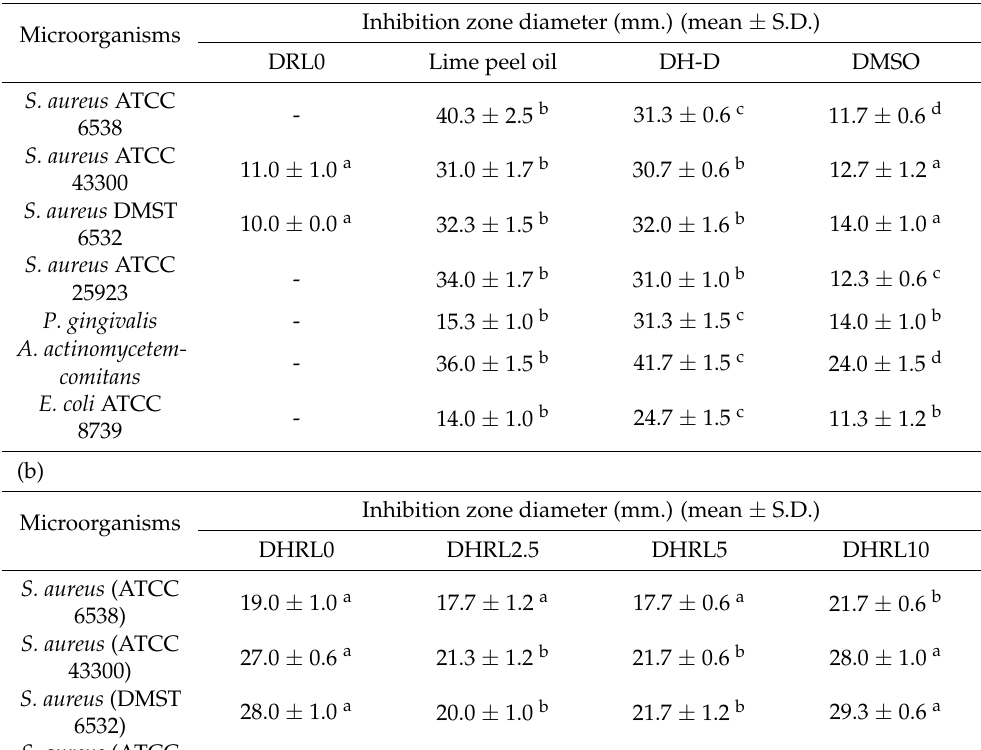
Table 3. Inhibition zone diameters (mm) against tested microorganisms; (a) control groups of drug- free-RL0, LO, DH in DMSO (D) and DMSO solvent; (b) different in situ forming gel formulations of 5% DH and 0, 2.5, 5, and 10% LO. Results are indicated as mean values ± SD, (n =